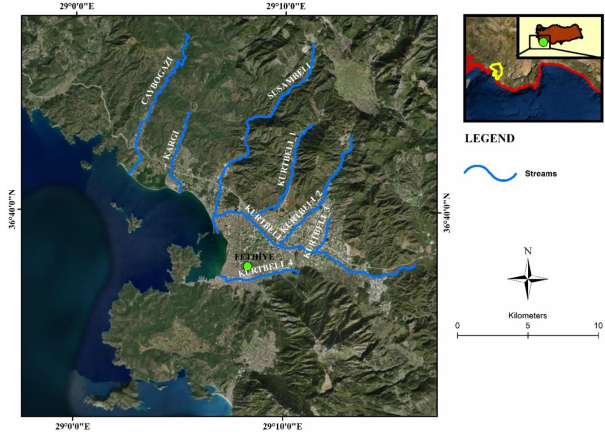
Figure 8. Stream network of the selected region (sources: Esri, Maxar, GeoEye, Earthstar Geographics, CNES/Airbus DS, USDA, USGS, AeroGRID, IGN, and the GIS User